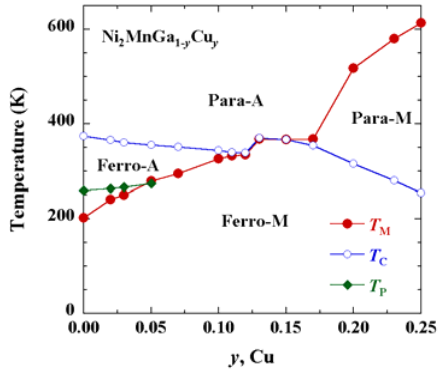
MnGa Cu (0 ≤ y ≤ 0.25) alloys [10]. Para and 2 1 − y y